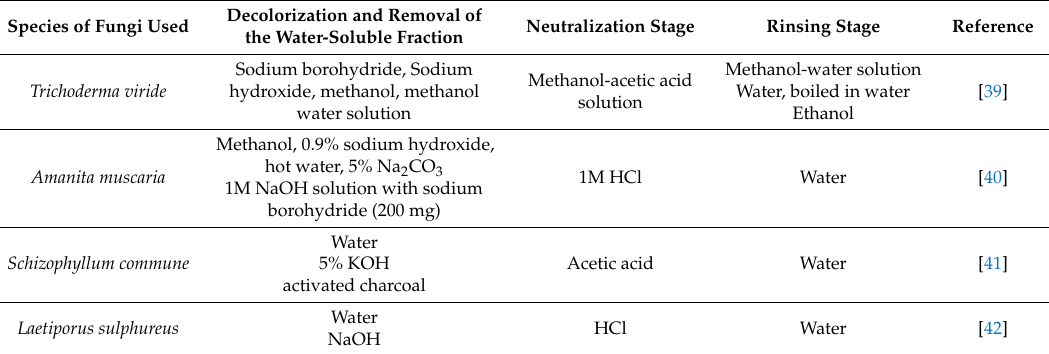
Table 2. Summary of α -glucans isolation methods detailing the reagents used in each isolation step. Species of Fungi